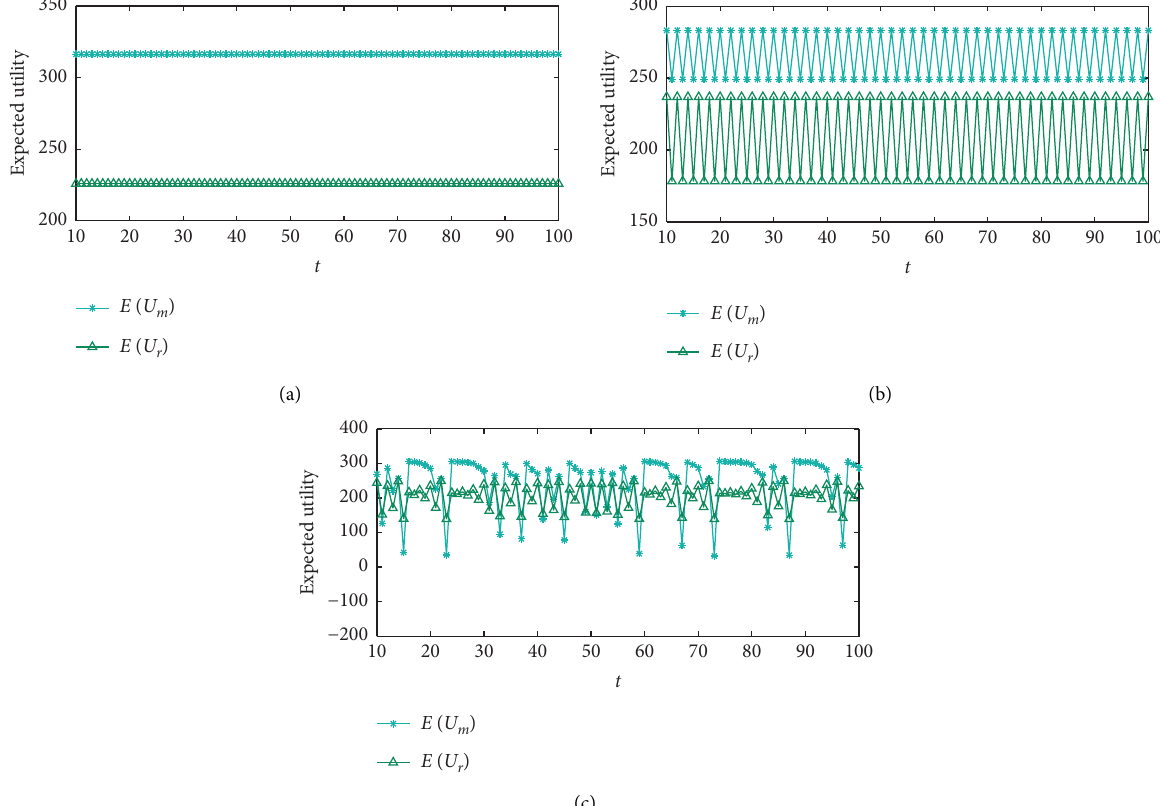
� 0 . 005. (b) δ � 0 . 024. (c) δ � 0 . 029. 1 1 1